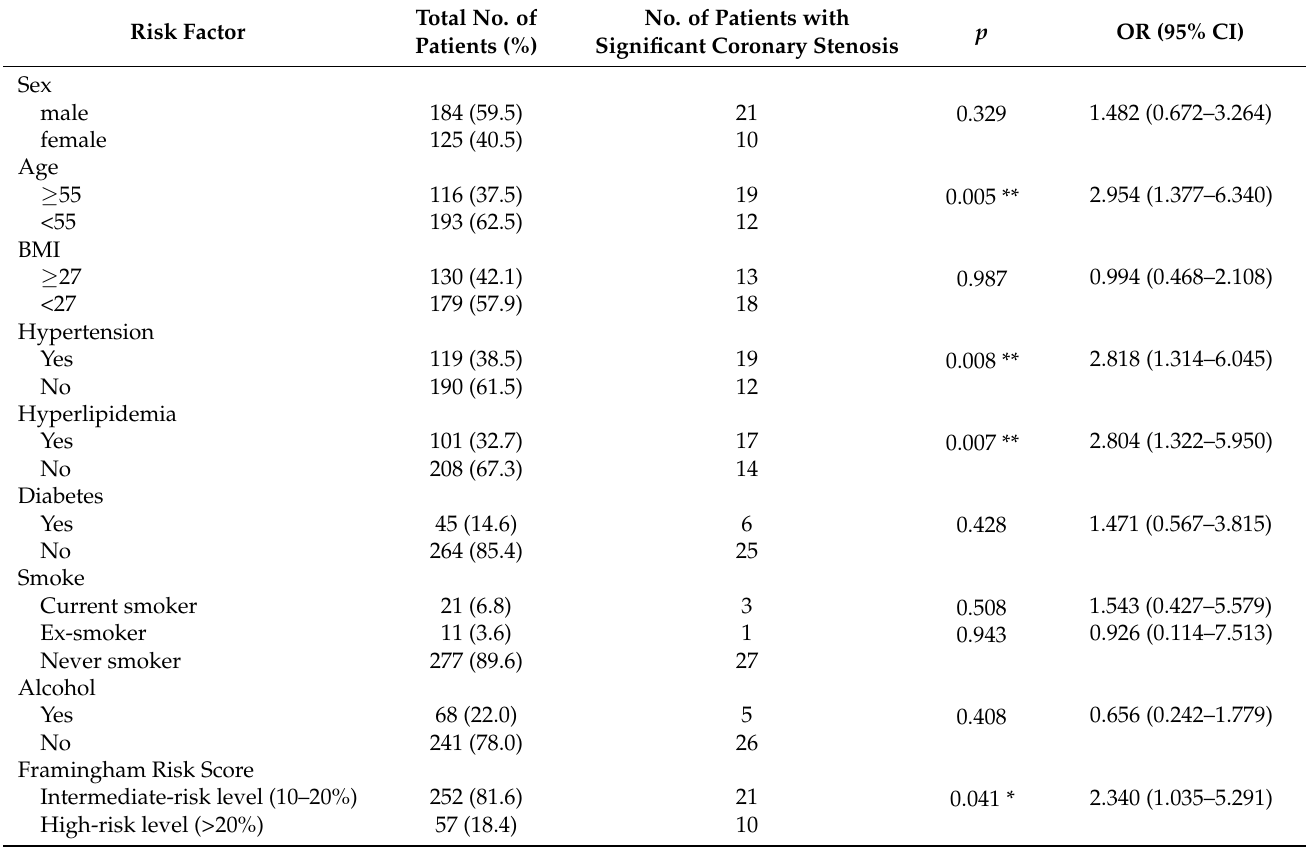
Table 2. Prevalence of CCTA-detected significant coronary stenosis in various risk factor subgroups ( n = 309). Risk Factor